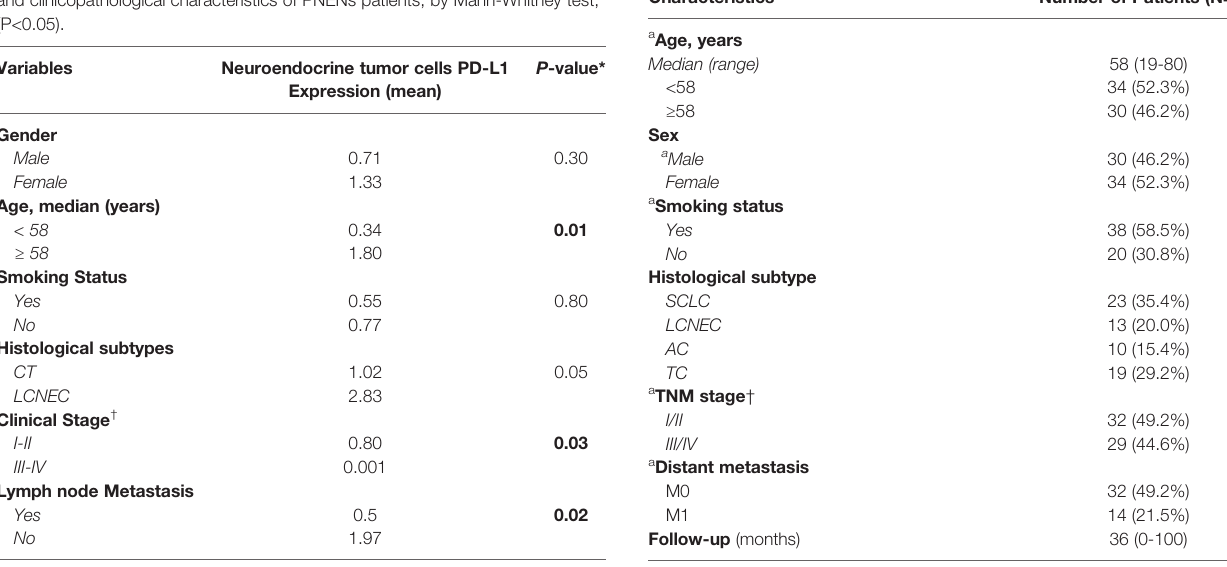
SNAI2 (47.8%, P=0.039) (see Supplementary Figure S2 ). We